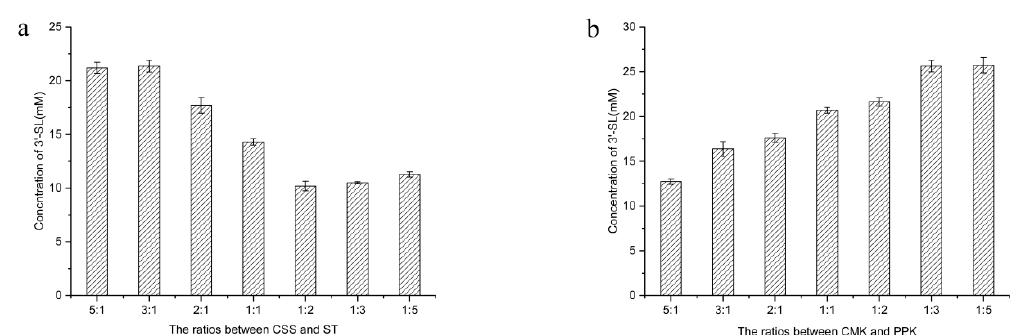
Figure 8. Optimization of the ratios between four cell-free extracts for 3 ′ -SL biotransformation. ( a ) ( a ) the ratios between CSS and ST; ( b ) the ratios between CMK and the ratios between CSS and ST; ( b ) the ratios between CMK and PPK.